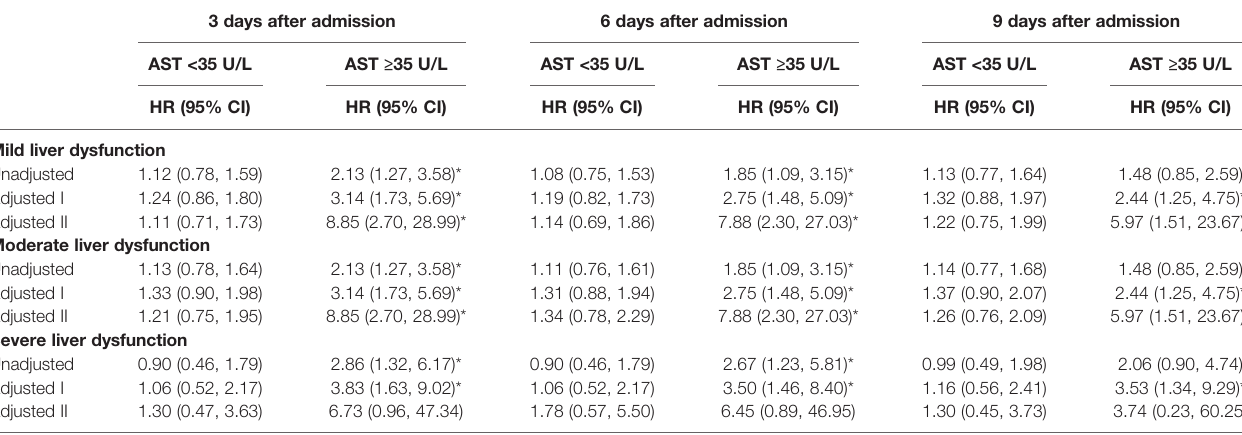
TABLE 4 | Longitudinal threshold effect analyses for the relations between b.LLCHN and the incidence of 3-, 6-, and 9-day liver